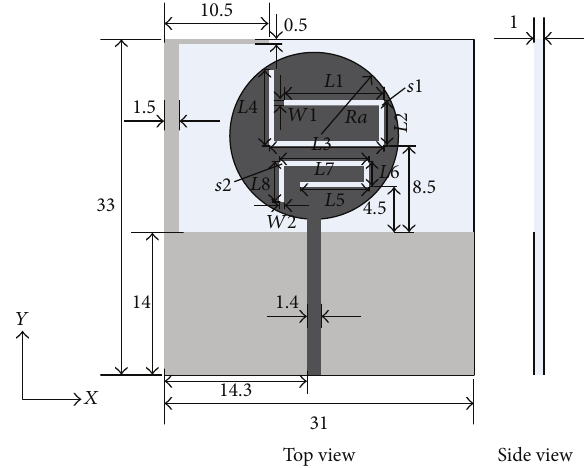
Figure 2: Fabricated prototypes. (a) The compact broadband antenna. (b) The proposed triple-band antenna.